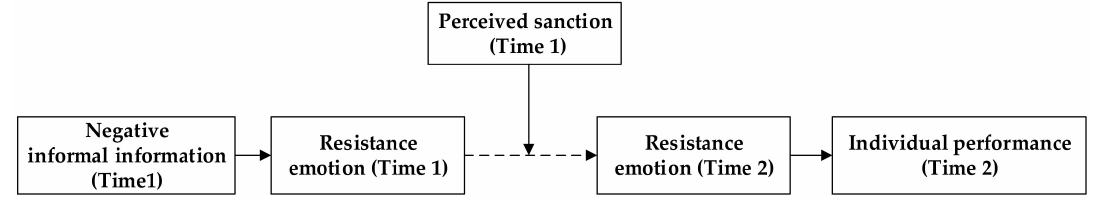
Figure 1. Conceptual